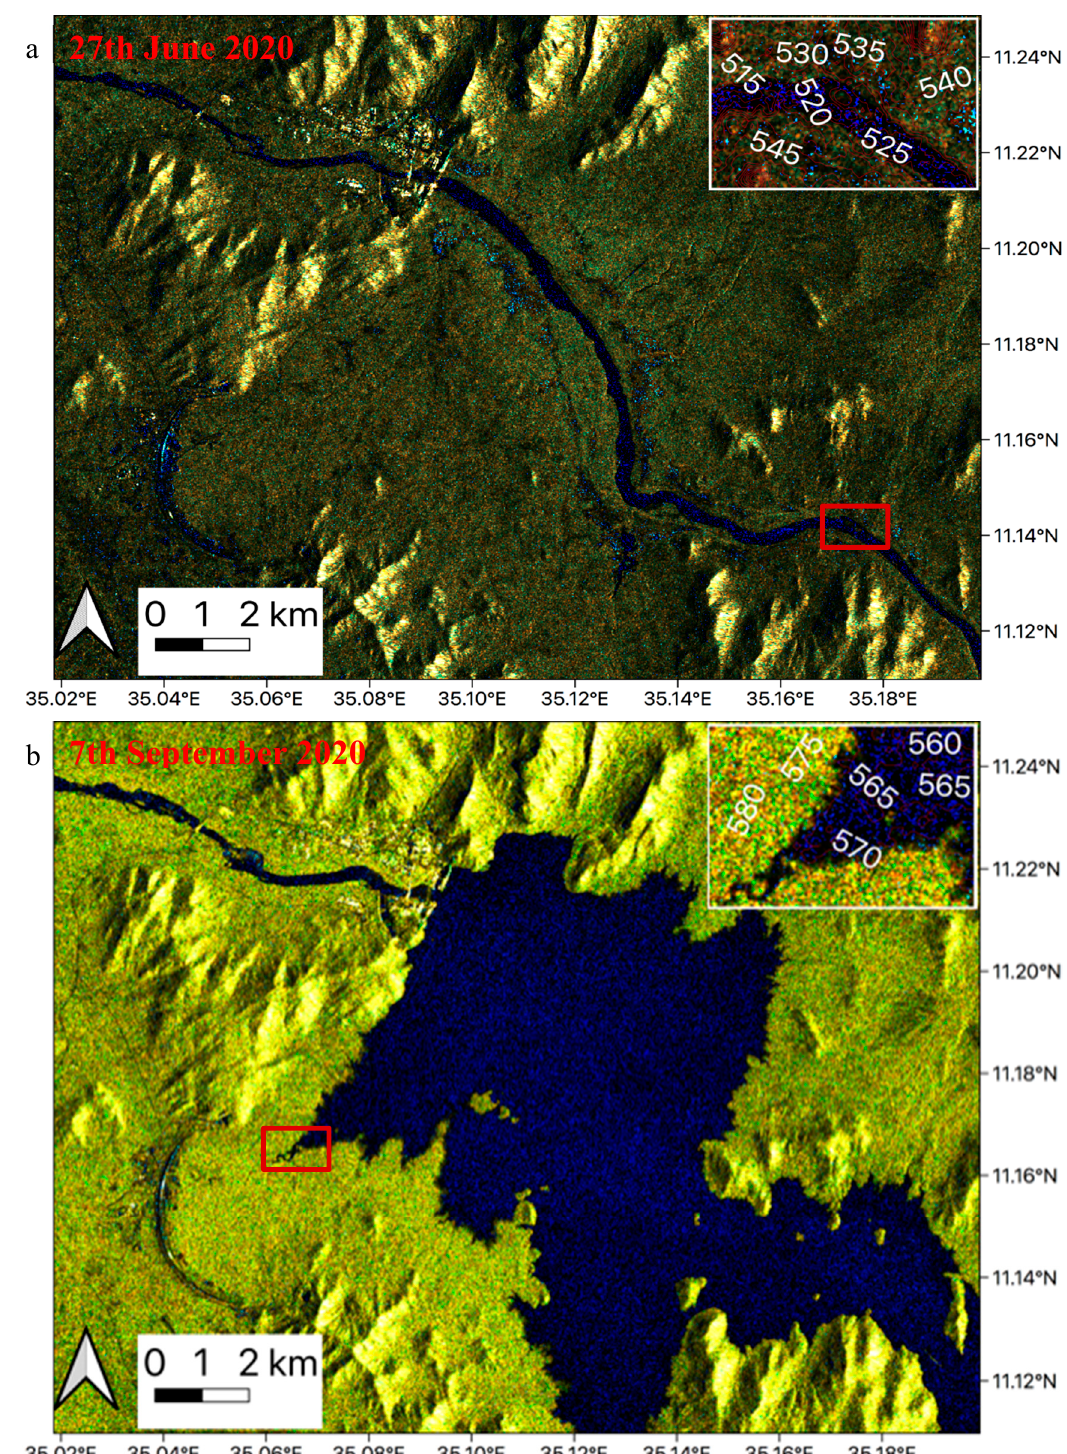
Figure 2. ( a ) Sentinel-1 for 27 June 2020 (prior to the filling process) and ( b ) 7 September 2020 (after the start of the filling process). The increased spatial extent of the reservoir can be observed in the second image on 7 September 2020. The inset figure shows the zoomed view of the region inside the red box to study the elevation contours inside the region. The contour values shown in the inset figure are in meters.